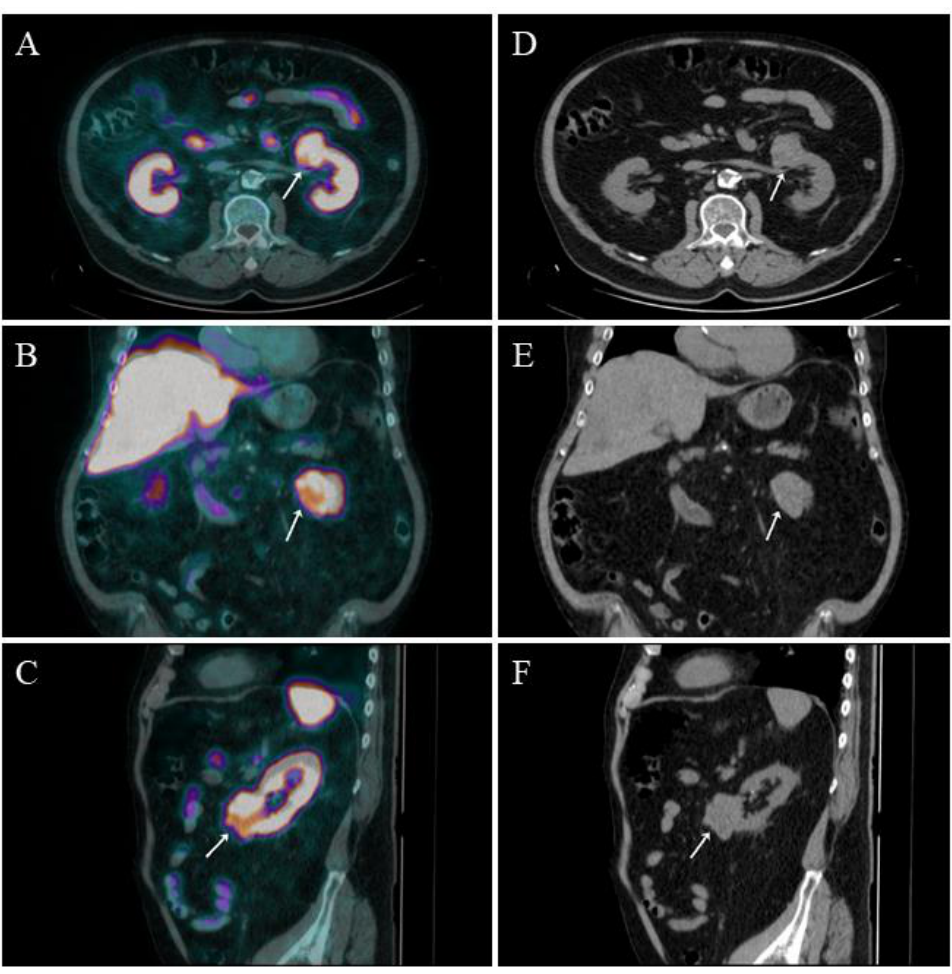
Figure 3. A 64-years old man with diagnosis of prostate adenocarcinoma previously treated through robot-assisted radical prostatectomy and pelvic lymph-node dissection in 2016 (pT2apN0c; Gleason score 4 + 3) came to our attention in February 2022 for biochemical recurrence (PSA value: 0.64 ng/mL) and underwent 18 F-PSMA-1007 PET/CT. PET/CT scan was performed 90 min after 250 MBq 18 F-PSMA-1007 administration. PET/CT images did not show any sign of suspect local recurrence nor distant metastases distinctly attributable to prostate cancer. Nevertheless, in the upper abdomen sections (( A ) fused PET/CT axial, ( B ) fused PET/CT coronal, ( C ) fused PET/CT sagittal, ( D ) low-dose CT axial, ( E ) low-dose CT coronal; ( F ): low-dose CT sagittal), an area of abnormal and intense 18 F-PSMA-1007 uptake was observed in an exophitic lesion located at the lower pole of the left kidney (white arrow). After routine diagnostic work up, the patient was submitted to total nephrectomy and histologic examination was consistent with the diagnosis of